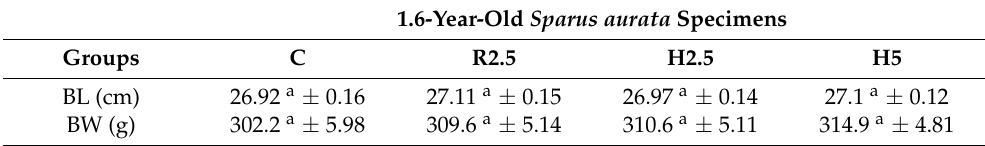
Table 2. Body growth parameters of adult specimens of Sparus aurata .